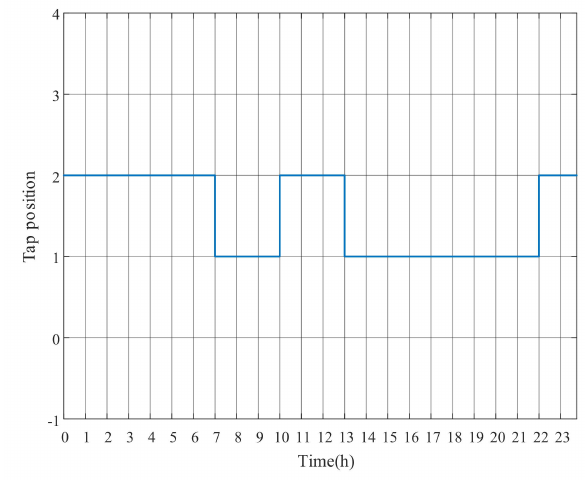
Figure 8. OLTC tap changes with DRM